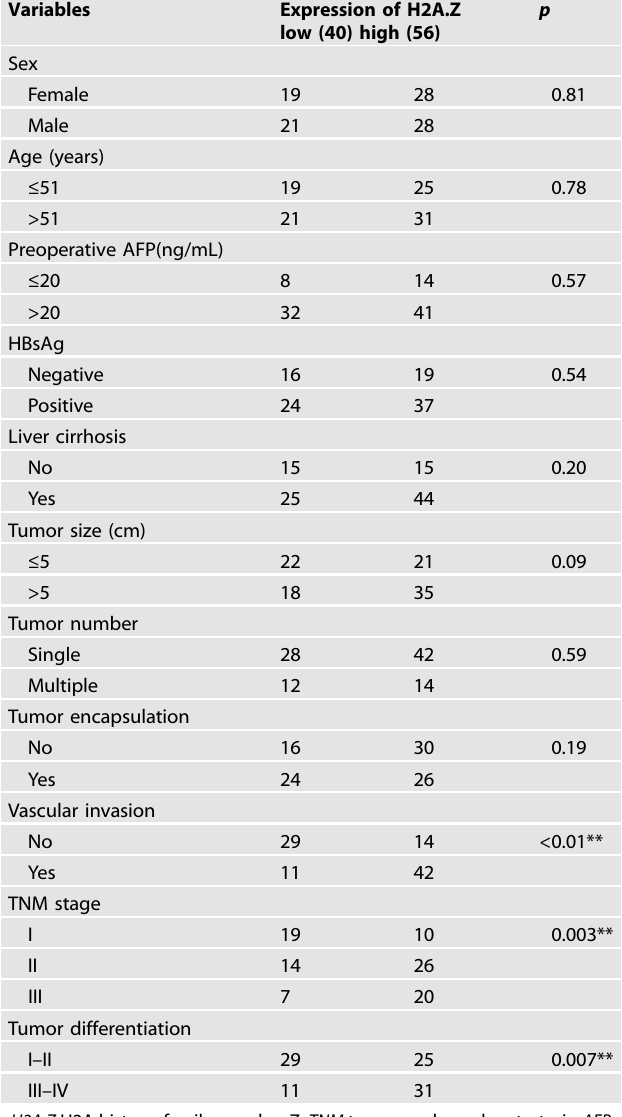
Table 2. Expression of H2A.Z by immunohistochemical and clinicopathologic features of HCC patients ( n =